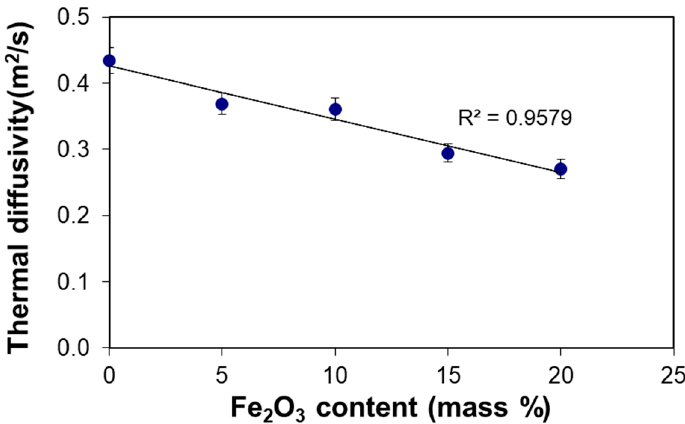
Figure 8. Thermal diffusivity of the lime mortar versus iron (III) oxide content.